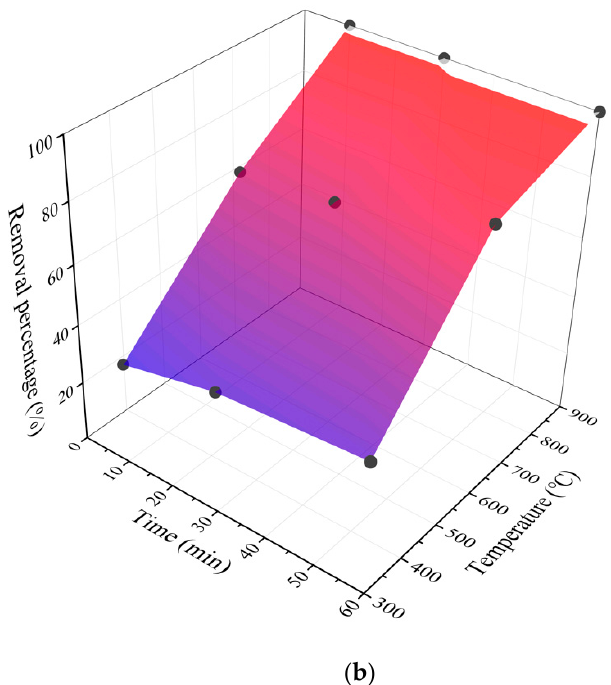
Figure 3. Removal percentage of 10,000 ppm of pollutant with different treatment parameters. ( a ) Gasoline; ( b ) Diesel.